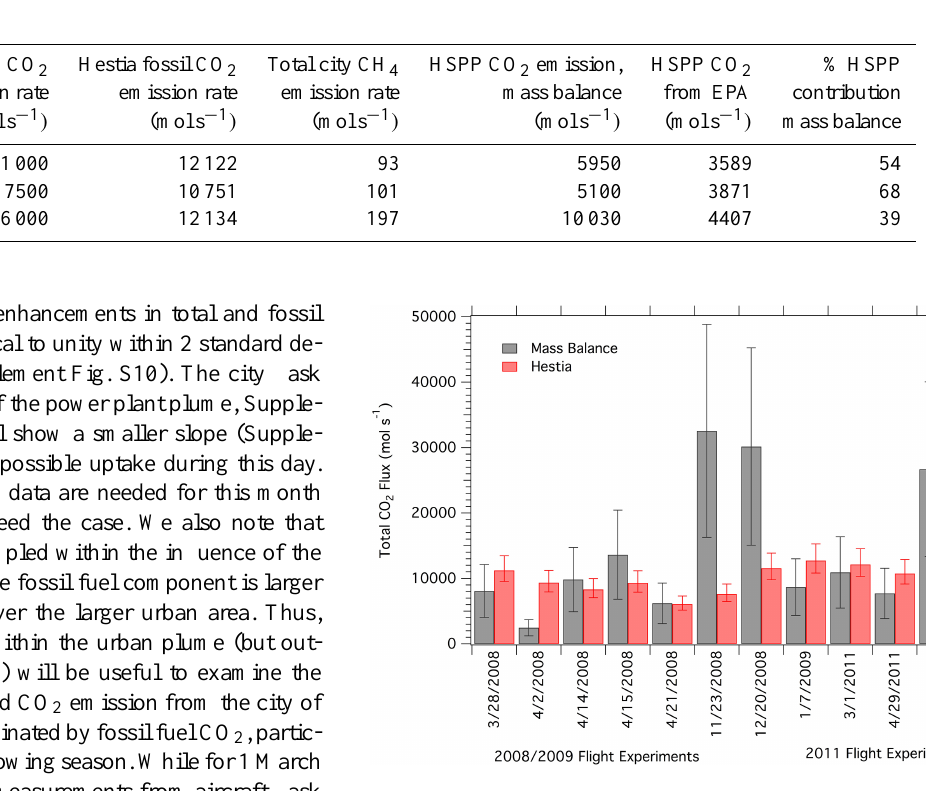
Table 1. Citywide CO 2 and CH 4 emissions estimated from the aircraft-based mass balance approach and the Hestia bottom-up method corresponding to the three flight dates. Total uncertainty in the Hestia county-level emissions is ( − 15, + 20%) at 95% confidence interval. Also shown are the Harding Street power plant (HSPP) CO 2 emissions from the mass balance approach and EPA stack measurements, and the mass balance HSPP percentage contribution to the total citywide CO 2 flux for the three flight dates. Uncertainty in the HSPP stack monitoring is 29%.